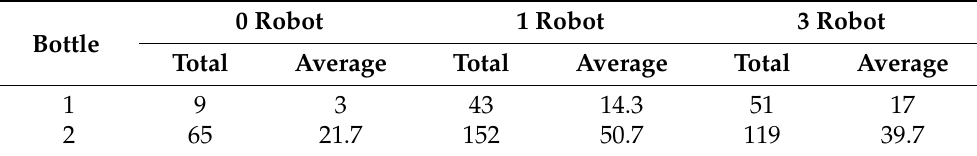
Table 3. Proportion of sanitizer usage (g) per